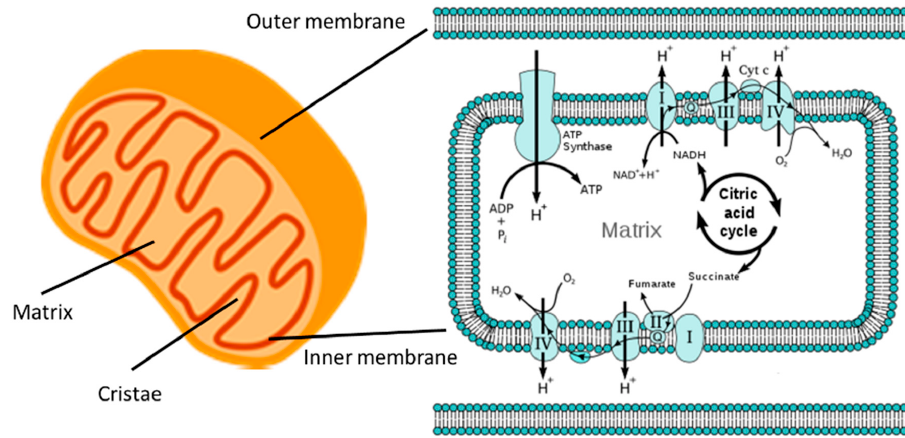
Figure 1. The mitochondria are the powerhouses of the cell. Left: A cartoon of a mitochondrion showing its outer and inner membranes, the cristae, and the matrix. Fat and sugar enter the mitochondria through channels of the outer membrane. Right: The Krebs, or citric acid, cycle feeds the chain of respiratory complexes I through IV which create an electrical and proton (H + ) gradient, the electromotive force across the inner membrane. ATP synthase utilizes the electromotive force to generate ATP from ADP and inorganic phosphate (P i ) (Right image from Wikipedia [24]).